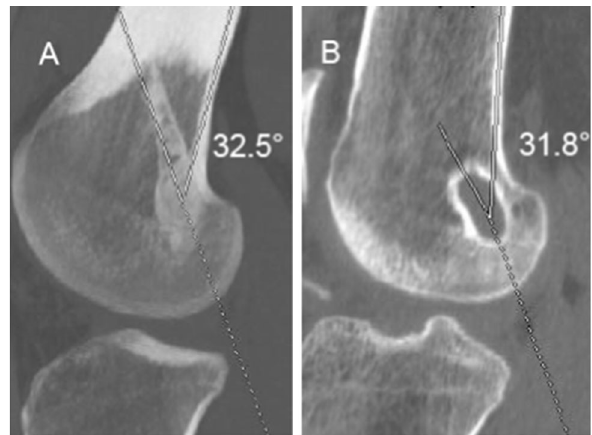
Fig. 1 Sagittal obliquity defined by the angle subtended between the tunnel and longitudinal axis of the femur. In this case, the angle is 32.5 (cid:3) for the in–out group ( a ) and 31.8 (cid:3) for the out–in group ( b )